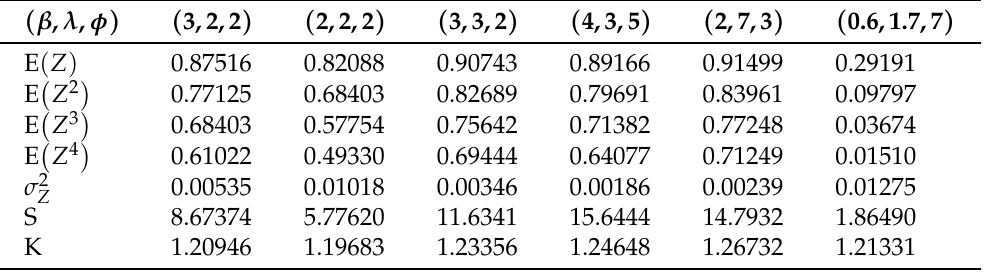
Table 1. Some moments, variance, skewness and kurtosis of Z for different parametric